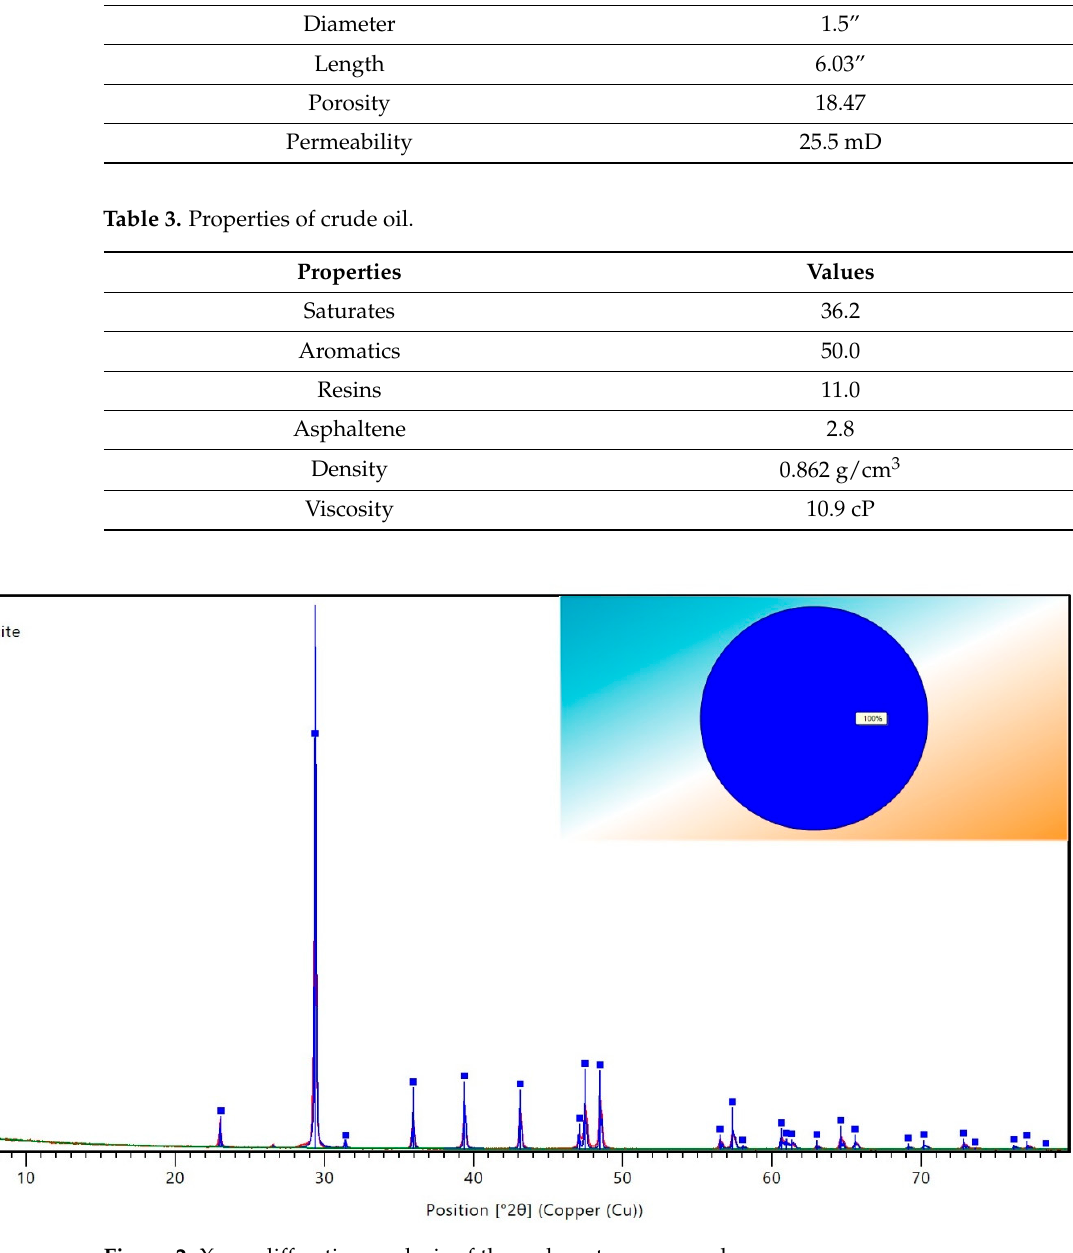
Figure 2. X-ray diffraction analysis of the carbonate core sample.